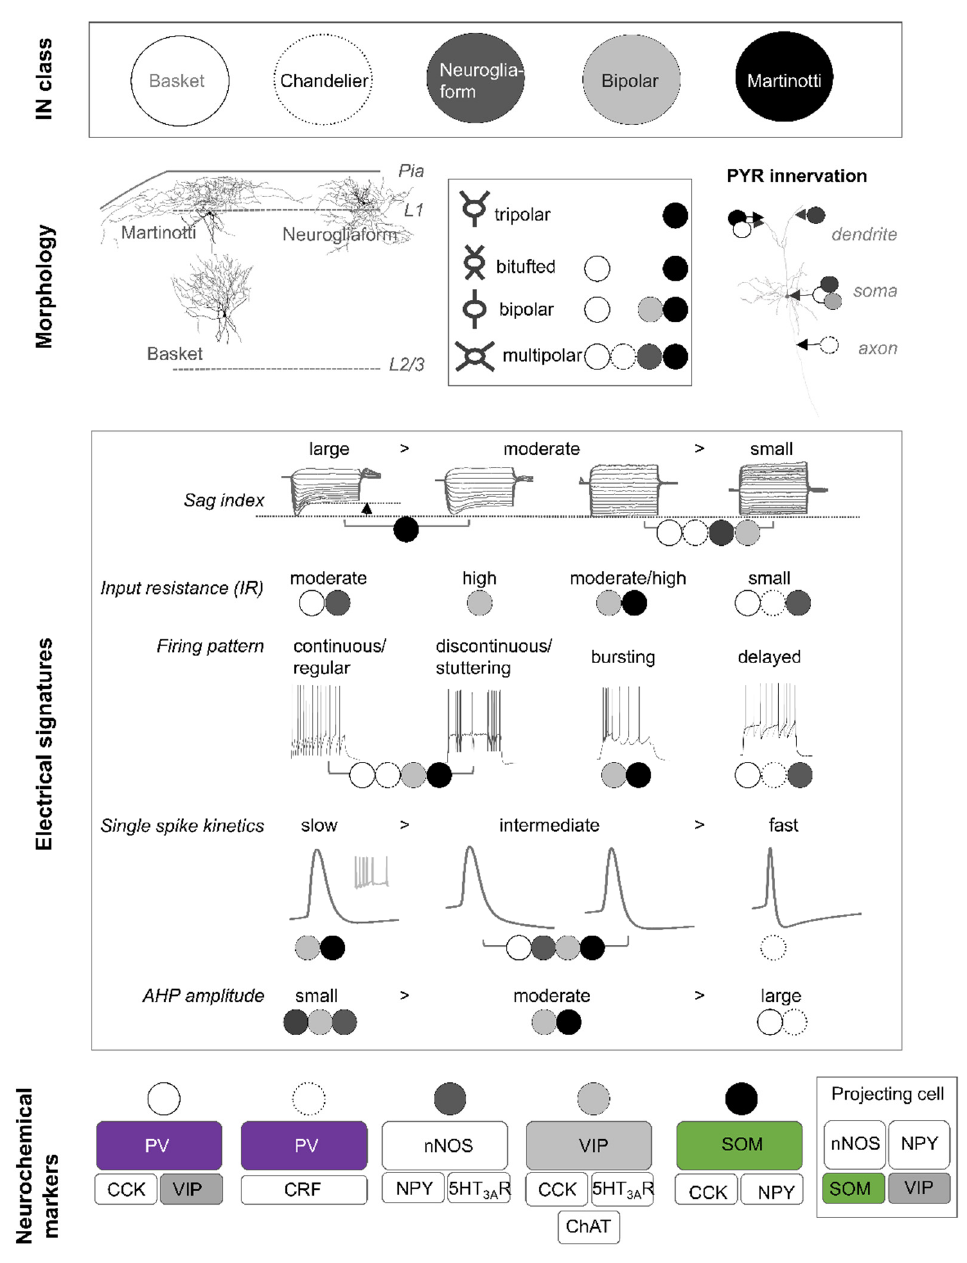
Figure 1. Overview of the major morphological interneuron types in the neocortex. Top: illustration of major morphological IN classes. Upper middle, left: representative reconstructions of Martinotti, neurogliaform, and basket cell type in the neocortex; middle: correlation of somatodendritic to morphological type; and right: schematic representation of preferred postsynaptic target of basket, Martinotti, neurogliaform, and bipolar cells on pyramidal cells (PYR). Lower middle: Schematic illustration of the electrical signatures of these four morphological IN types. Slow single spike kinetics are only observed in burst-spiking neurons. Bottom: expressed neurochemical markers in these IN subtypes. Abbreviations: AHP, afterhyperpolarisation; CCK, cholecystokinin; ChAT, choline acetyltransferase; L, cortical layer; nNOS, neuronal nitric oxide synthase; NPY, neuropeptide Y; PV, parvalbumin; PYR, pyramidal cell; SOM, somatostatin; VIP, vasoactive intestinal peptide; and 5HT 3A R, 5HT 3A receptor.